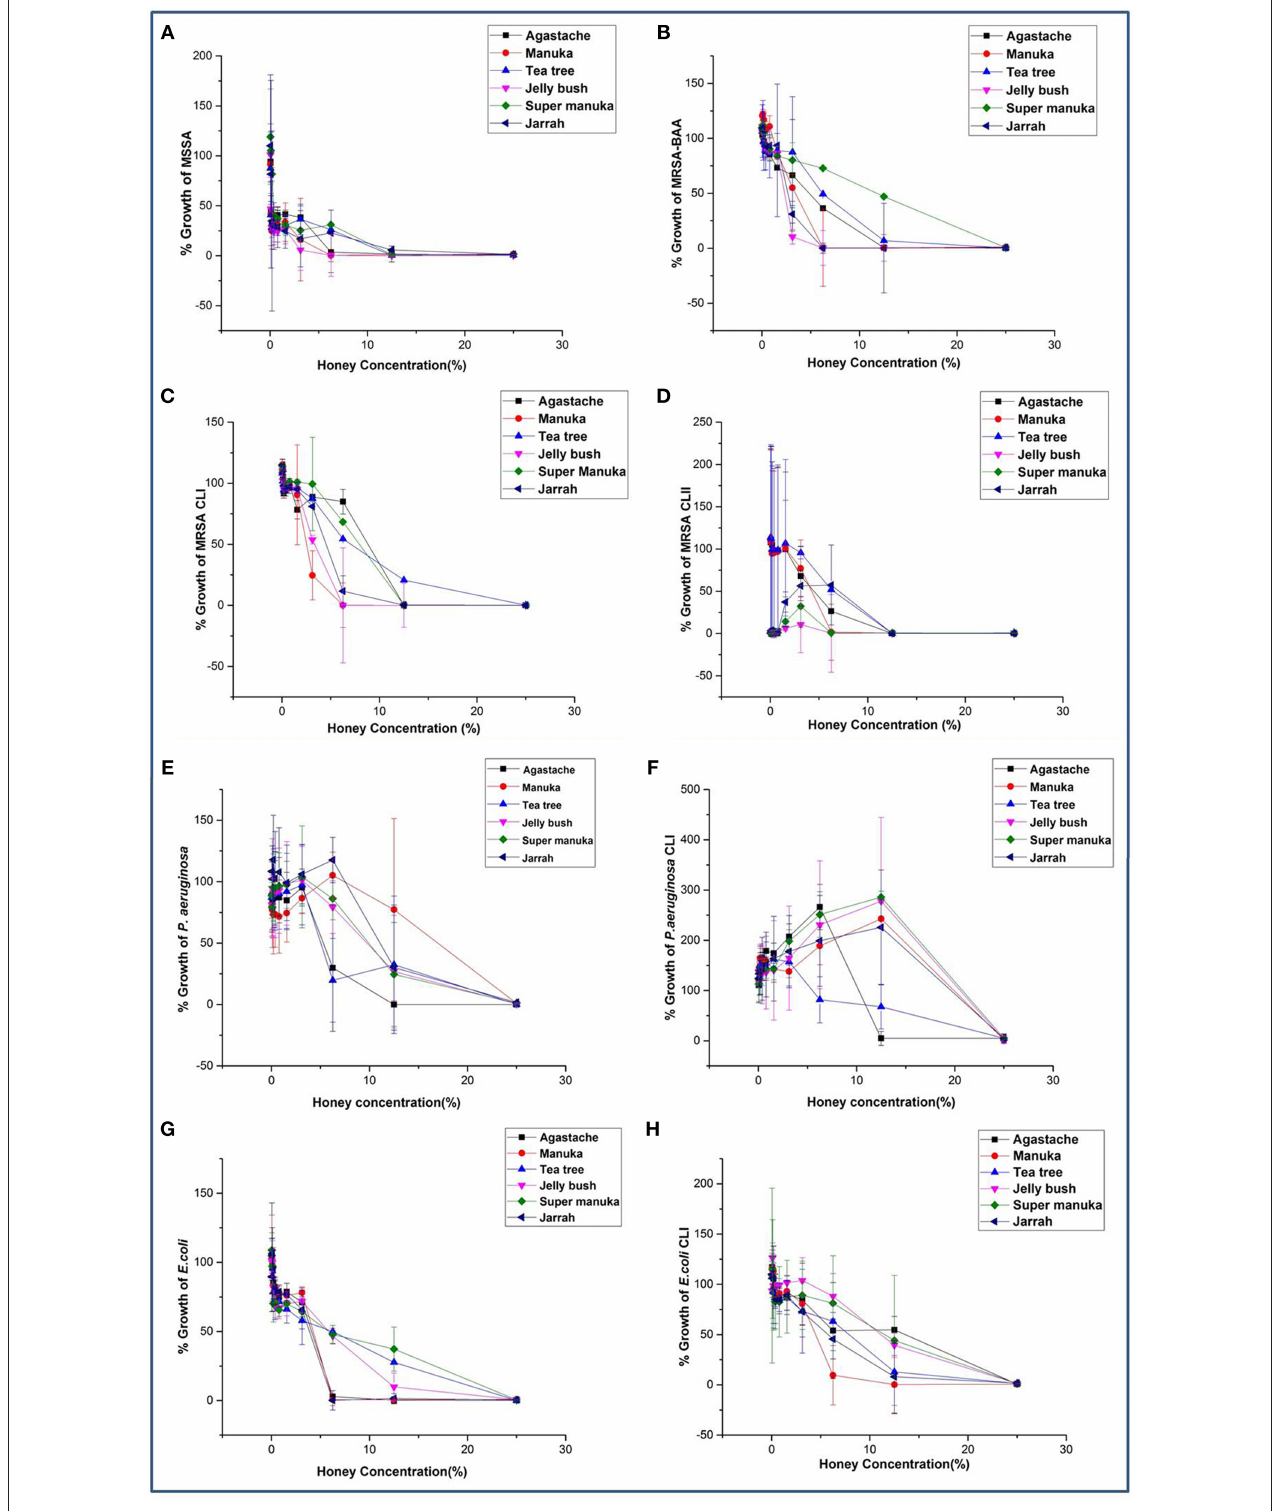
FIGURE 1 | (A–H) Antimicrobial activity of honey on bacterial species known to cause superficial skin infections.